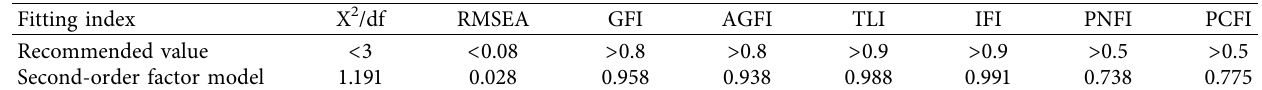
Table 4: CFA fitting index of external environment scale.